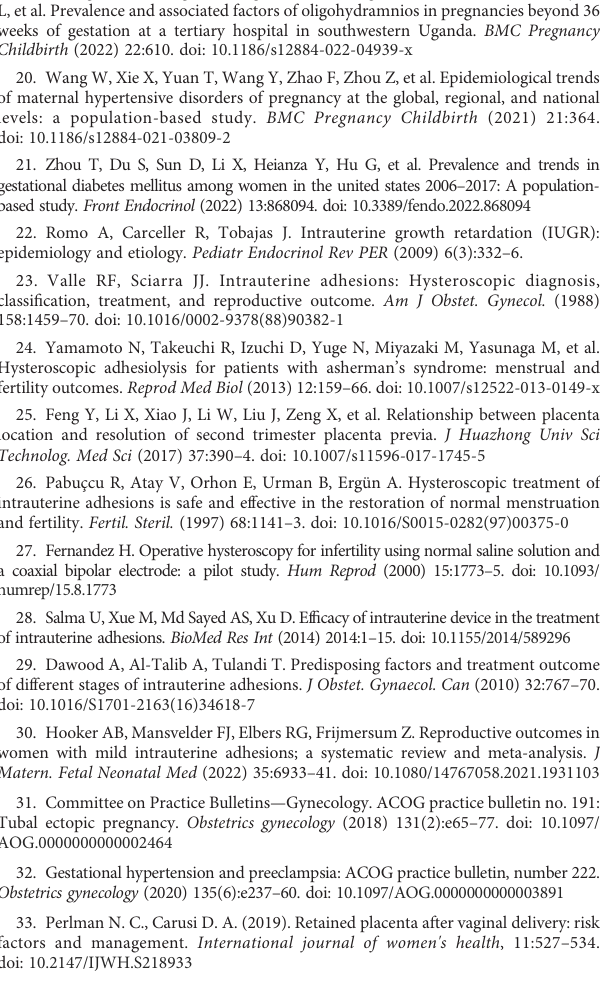
SUPPLEMENTARY FIGURE 2 The funnel plots of placenta accreta (A) , postpartum hemorrhage (B) and ectopic pregnancy (C) which have more than 10 studies